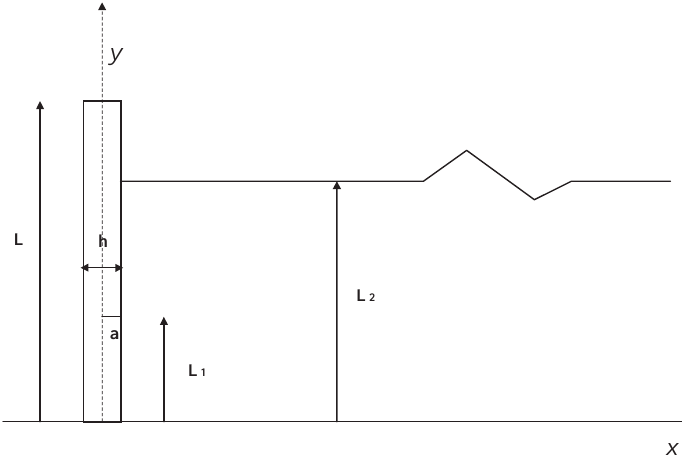
Fig. 1. The coupled system: a cracked beam interacting with a free surface